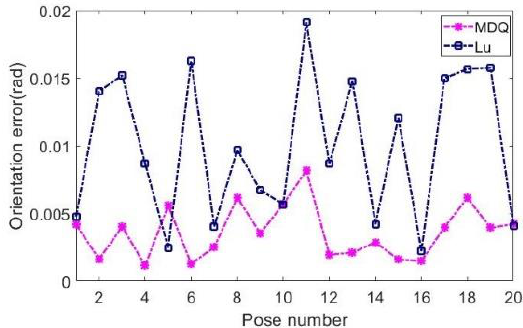
Figure 3. The RMS errors in rotation without noise interference.